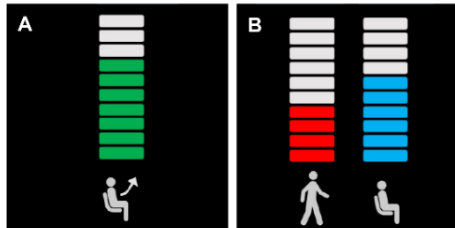
Figure 4. The illustration of the feedback buffer which represented the size of 10 of the exoskeleton BCI controller. ( A ) MI buffer is linked to the classifier_GvN (Gait MI vs. Do-nothing). ( B ) MI buffer is linked to the classifier_GvS (Gait MI vs. Sit MI).